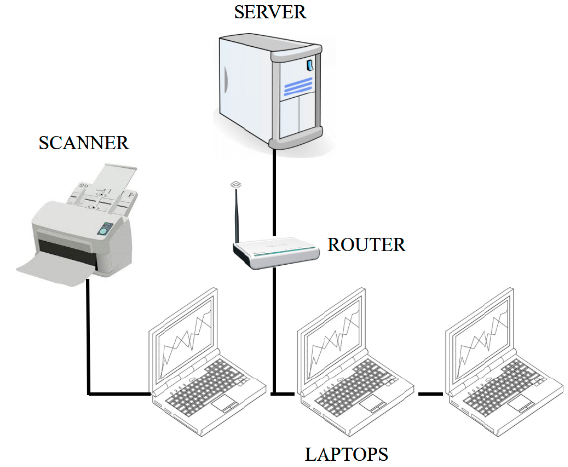
Figure 2. Main components of the pluviograph strip chart reader (PSCR).